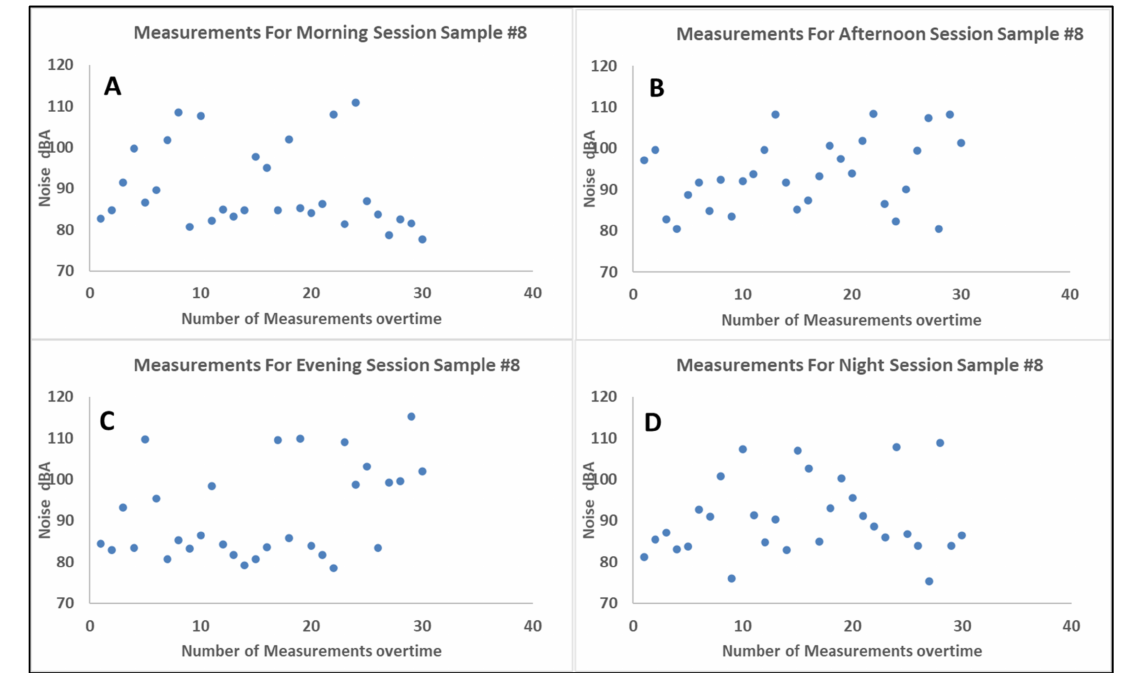
Figure 8. Raw noise sample data taken during: ( A ) morning, ( B ) afternoon, ( C ) evening, and ( D )